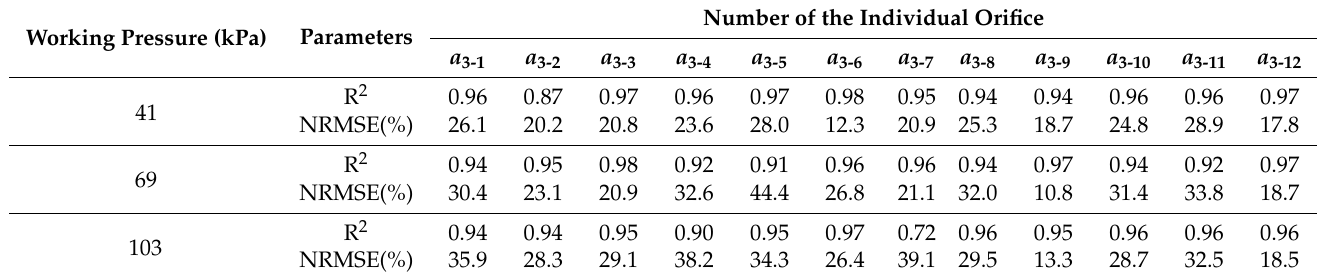
Table 2. The fitting evaluation parameters of bimodal two-dimensional Gaussian distribution model under three different working pressures for twelve individual